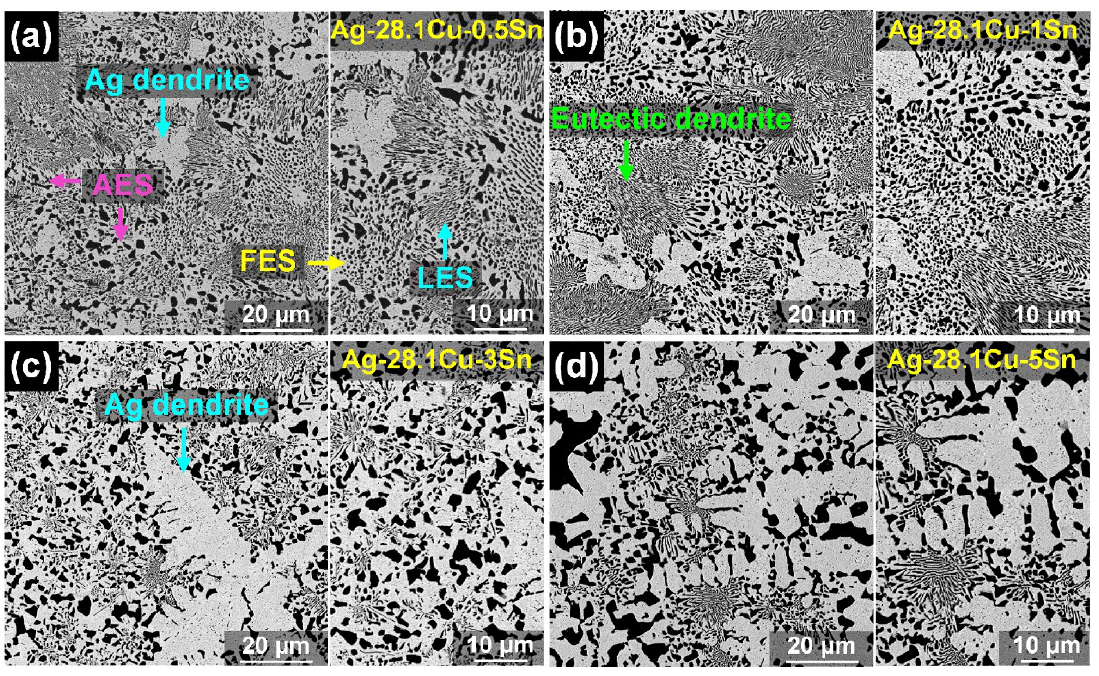
Figure 3. Eutectic morphologies in the Ag-Cu eutectic alloys solidified at 1 K/s with different Sn additions: ( a ) Ag-28.1Cu-0.5Sn, ( b ) Ag-28.1Cu-1Sn, ( c ) Ag-28.1Cu-3Sn and ( d ) Ag-28.1Cu-5Sn.